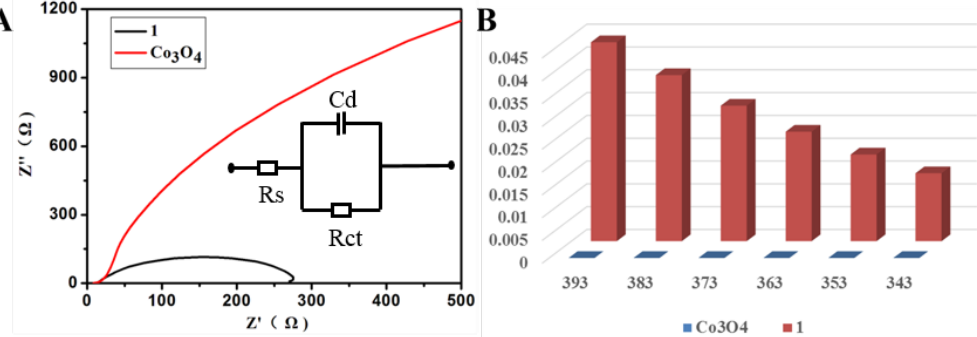
Figure 3. ( A ) Nyquist plots of 1 and benchmark Co 3 O 4 examined at 0.5 V (vs. Saturated calomel electrode SCE); and ( B ) TOFs of 1 and benchmark Co 3 O 4 at different overpotentials from 343 to 393 mV. Table 3. Comparison of OER catalytic performance of recently reported state of the art Co-based and MOF-based OER catalysts.